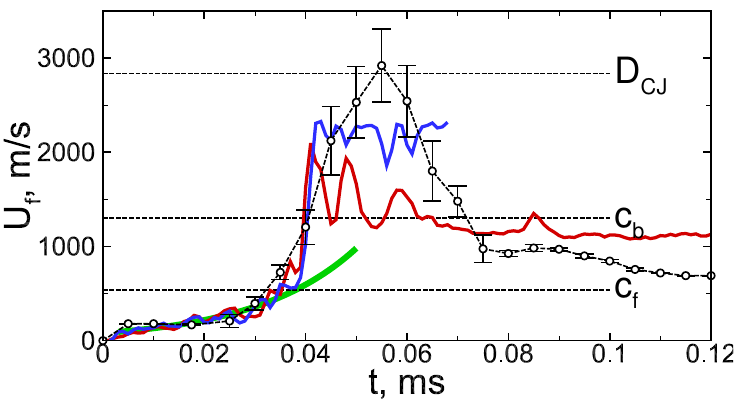
Figure 3. Time history of the flame speed in the microfoam bubbled with stoichiometric hydrogen– oxygen mixture. Signs connected with dashed lines—experimental data from [8], solid lines— numerical results with (red) and without (blue) account of droplet fragmentation. Green thick line shows the exponential approximation U f = 80 × exp ( 50 × 10 − 3 t ) , illustrating the self-sustained flame acceleration within time interval from 3 µ s to 40 µ s before transition to detonation. Horizontal dashed lines show the characteristic velocity scales for hydrogen–oxygen: c f —sonic speed in the fresh gas mixture, c b —sonic speed in the combustion products, D CJ —Chapman–Jouguet detonation